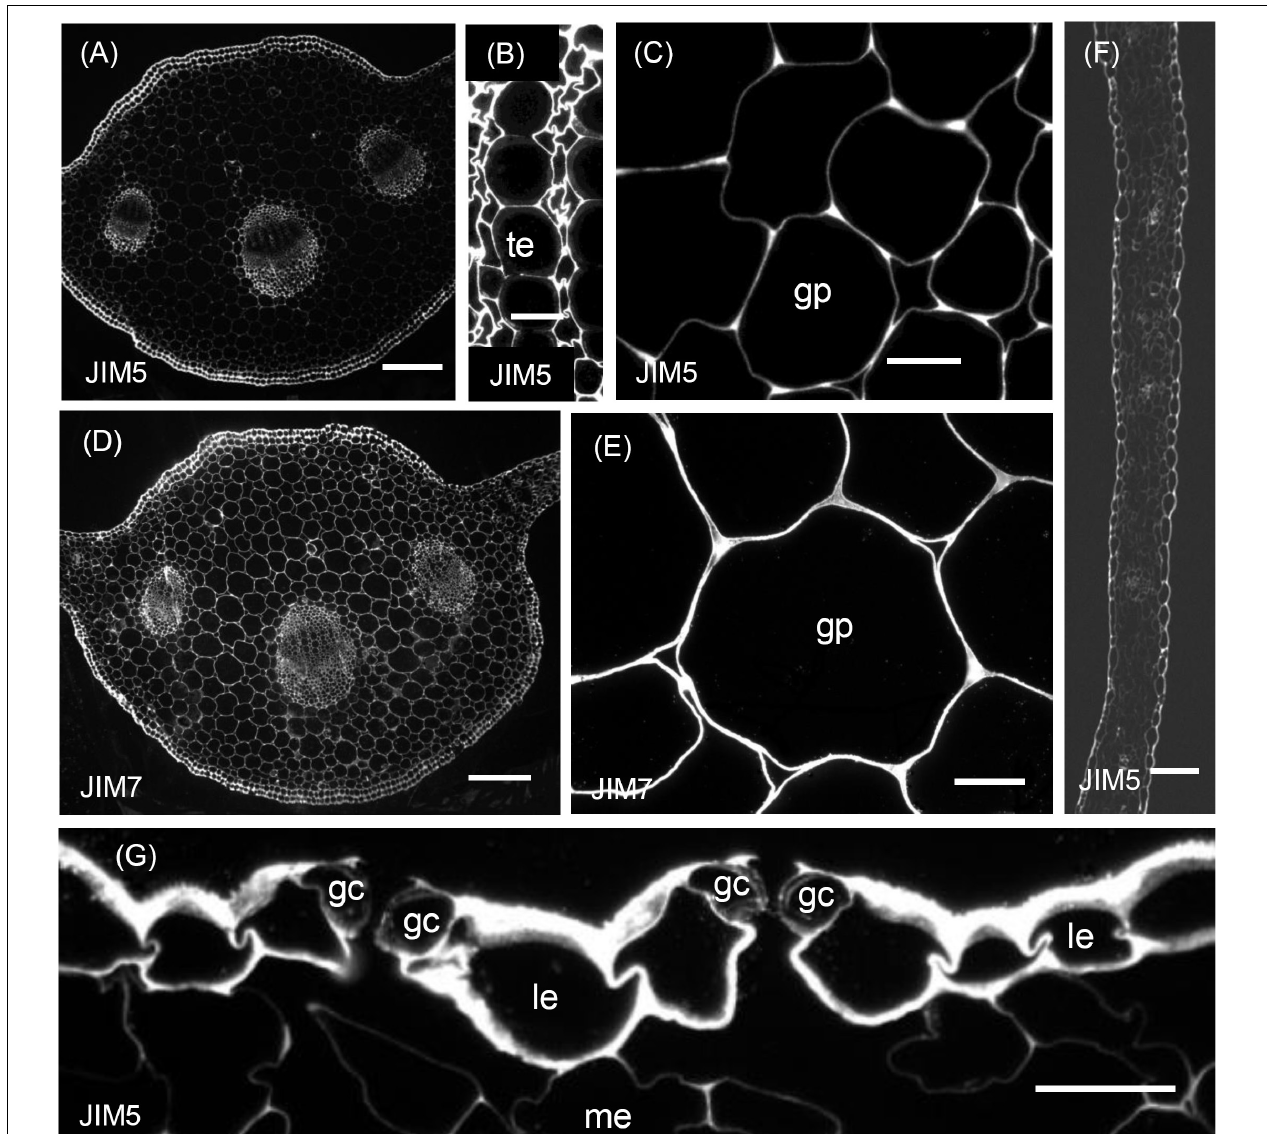
FIGURE 2 | Immunofluorescence micrographs of transverse sections cut from a rosette leaf from an 8-week-old chicory plant and labelled with JIM5 or JIM7. (A) The midrib labelled with JIM5. (B) Xylem tracheary elements and adjacent xylem parenchyma cells in a vascular bundle in the midrib labelled with JIM5. (C) Parenchyma cells (ground parenchyma) between the midrib hypodermis and the vascular bundles, showing more intense JIM5 labelling at the cell corners. (D) The midrib labelled with JIM7. (E) Parenchyma cells (ground parenchyma cells) between the midrib hypodermis and the vascular bundles labelled with